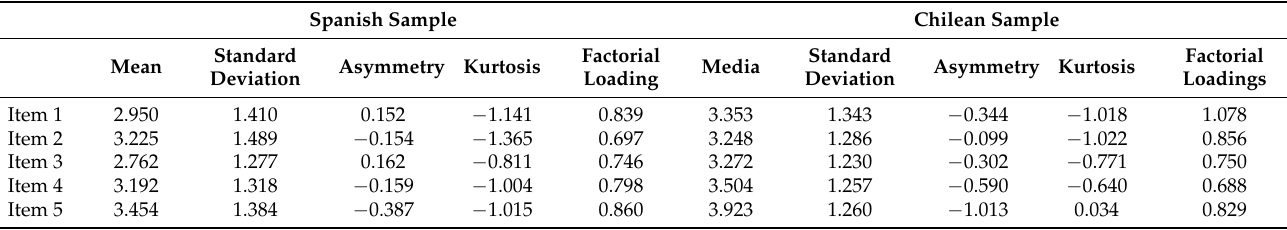
Table 1. Descriptive statistics and factor loading of confirmatory factor